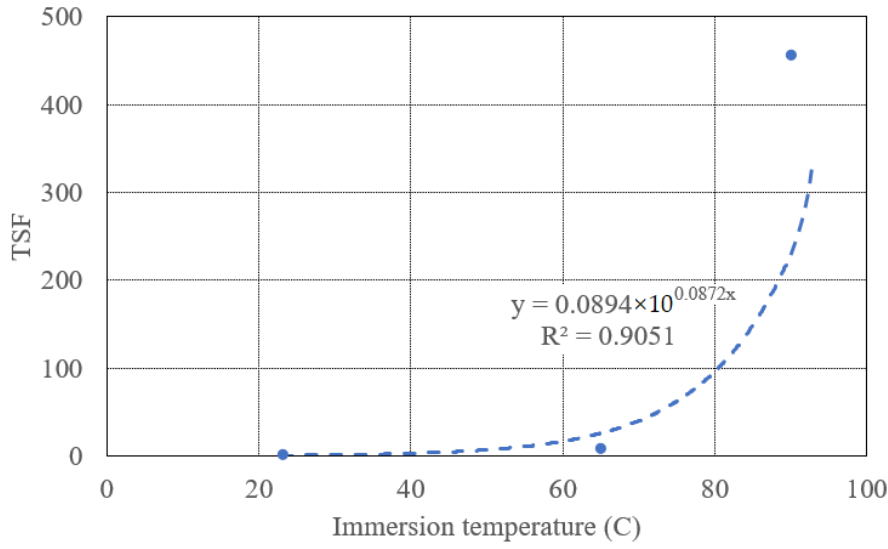
Figure 14. The TSF values versus temperature for E-glass epoxy composite.